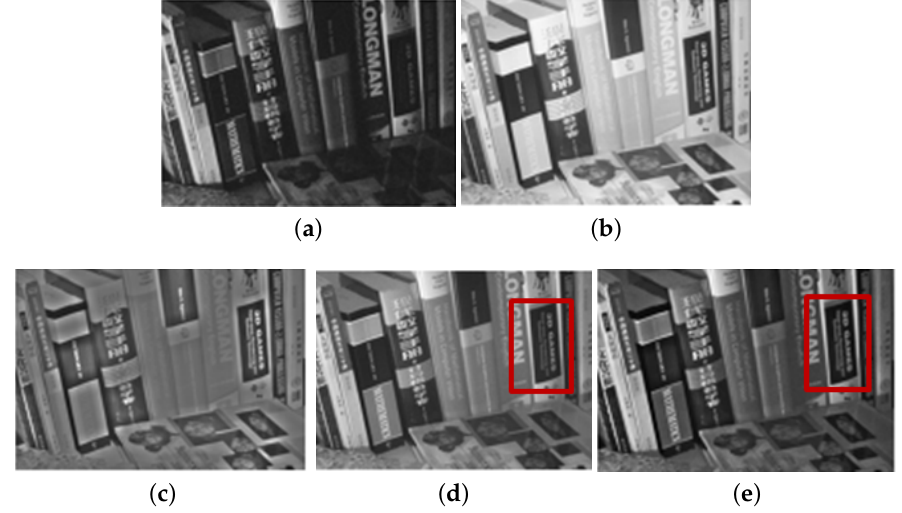
Figure 5. Fusion results of low-pass bands in Books . ( a ) RGB image. ( b ) NIR image. ( c ) α 0 . ( d ) Fusion without α . ( e ) Fusion with α